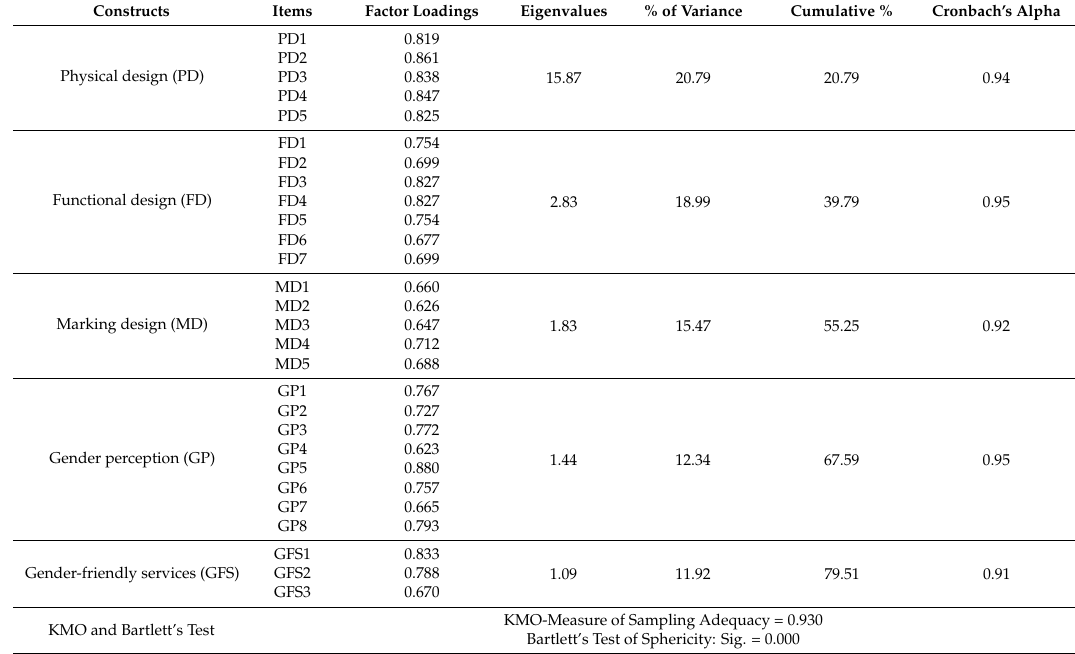
Table 2. Results of the constructs and items of the measurement scale (Study 1, n =